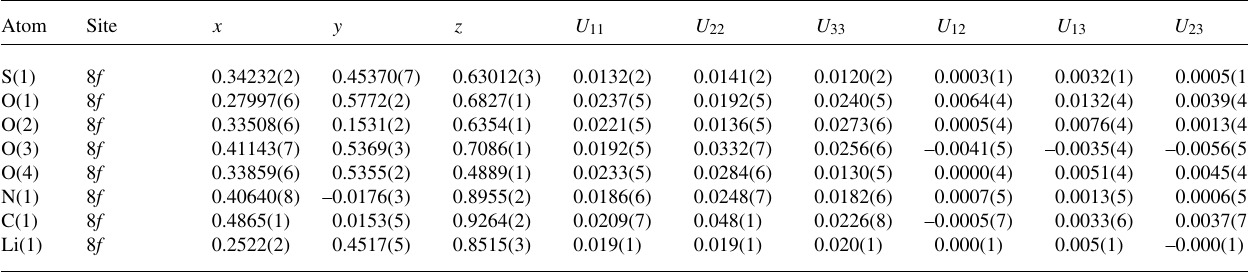
Table 3. Atomic coordinates and displacement parameters (in Å 2 )